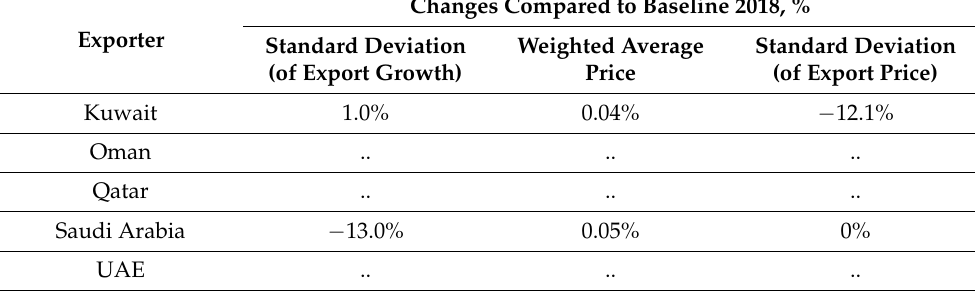
Table 7. Effects of decreased oil exports to the US.